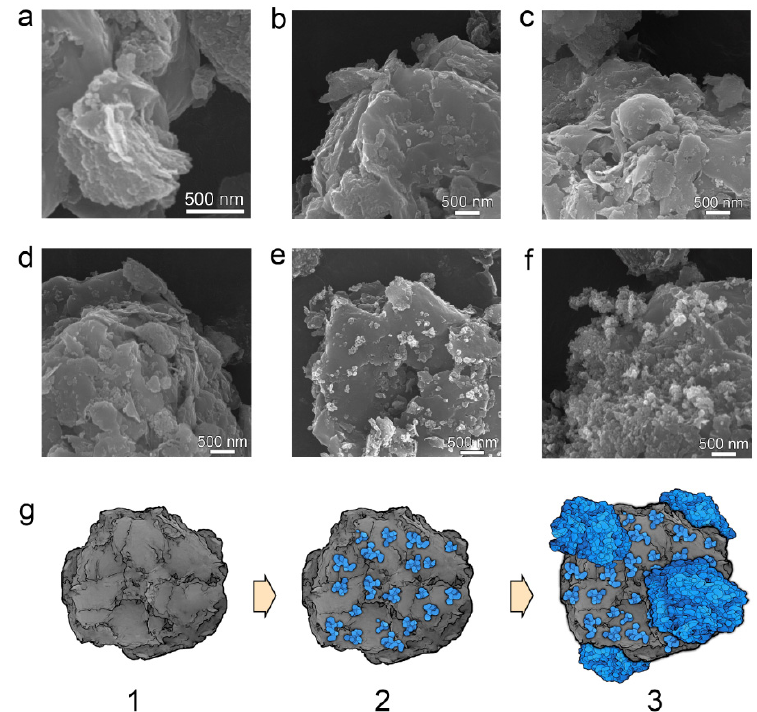
Figure 2. Distribution of ZnO on bentonite modified clay by dry dispersion methodology. Panels ( a ) to ( f ) show the micrographs of ZnO/clay after the incorporation of different ZnO concentrations—2% ( a ), 6% ( b ), 10% ( c ), 20% ( d ), 40% ( e ), 60% ( f ). Panel ( g) shows the steps of composite evolution according to ZnO concentration: (1) no ZnO addition, (2) ZnO concentration from 2% to 10%, (3) concentration upper than 20%.